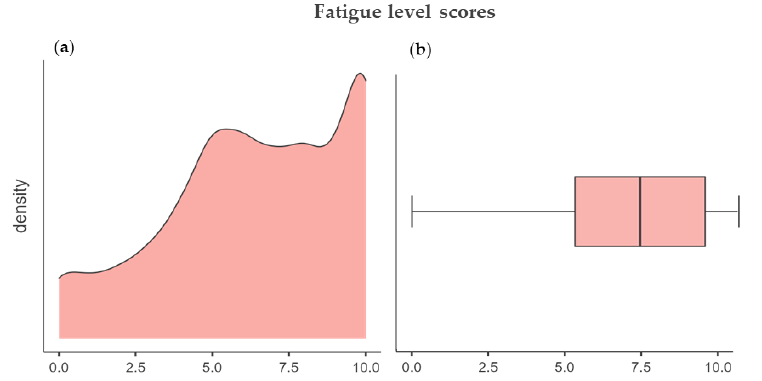
Figure 1. ( a ) A density plot showing the concentration of scores and ( b ) a boxplot showing the dif- ference of distribution.